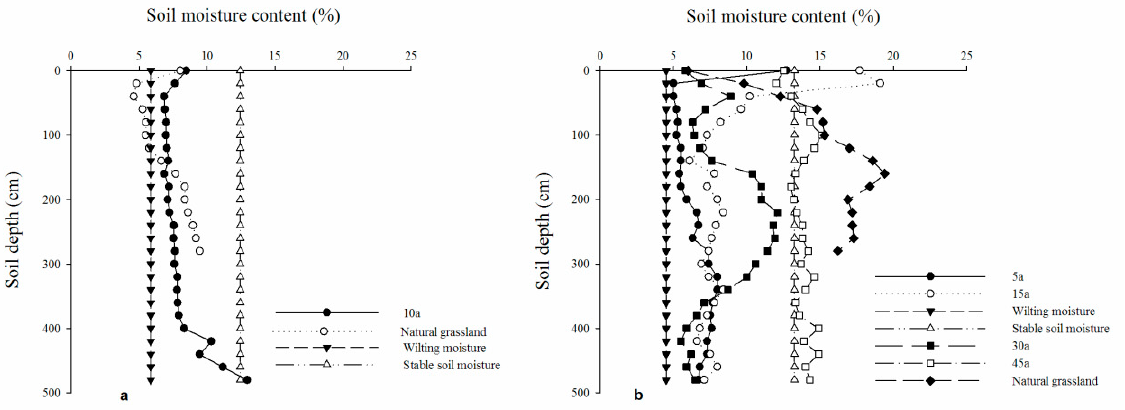
Figure 4. Distribution of desiccated-soil layers under R. pseudoacacia forests in the central, warm- temperate, semi-arid steppe zone of the Loess Plateau. Note, ( a , b ) in Figure 4 were represented as sampling sites in Yanchang and Yan’an, respectively .